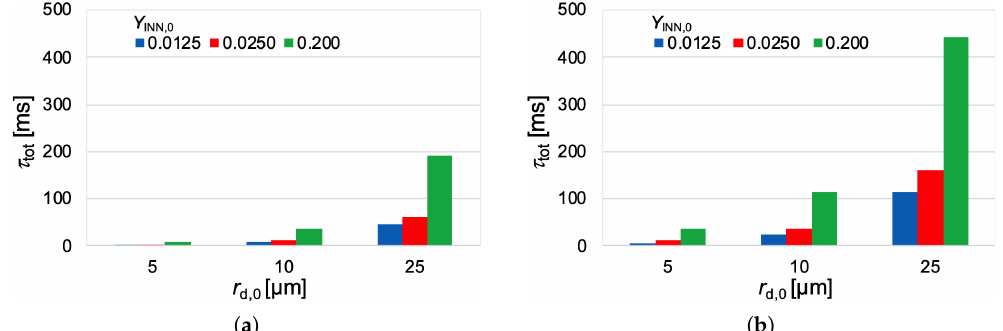
Figure 4. Total process times for different initial droplet radii and initial INN mass fractions of 0.0125, 0.025, and 0.200. Initial conditions: T l,0 = 293.15 K, p = 1 bar, T g,0 = 800 K. ( a ) u 0 = 4 m/s. ( b ) u 0 = 8 m/s.